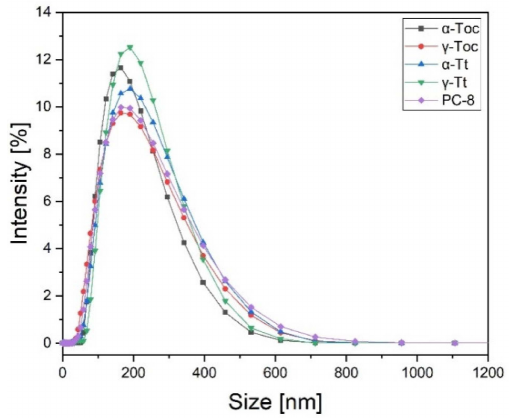
Figure 6. Intensity-based size distribution of the tocochromanol-loaded liposomes (averages of 5